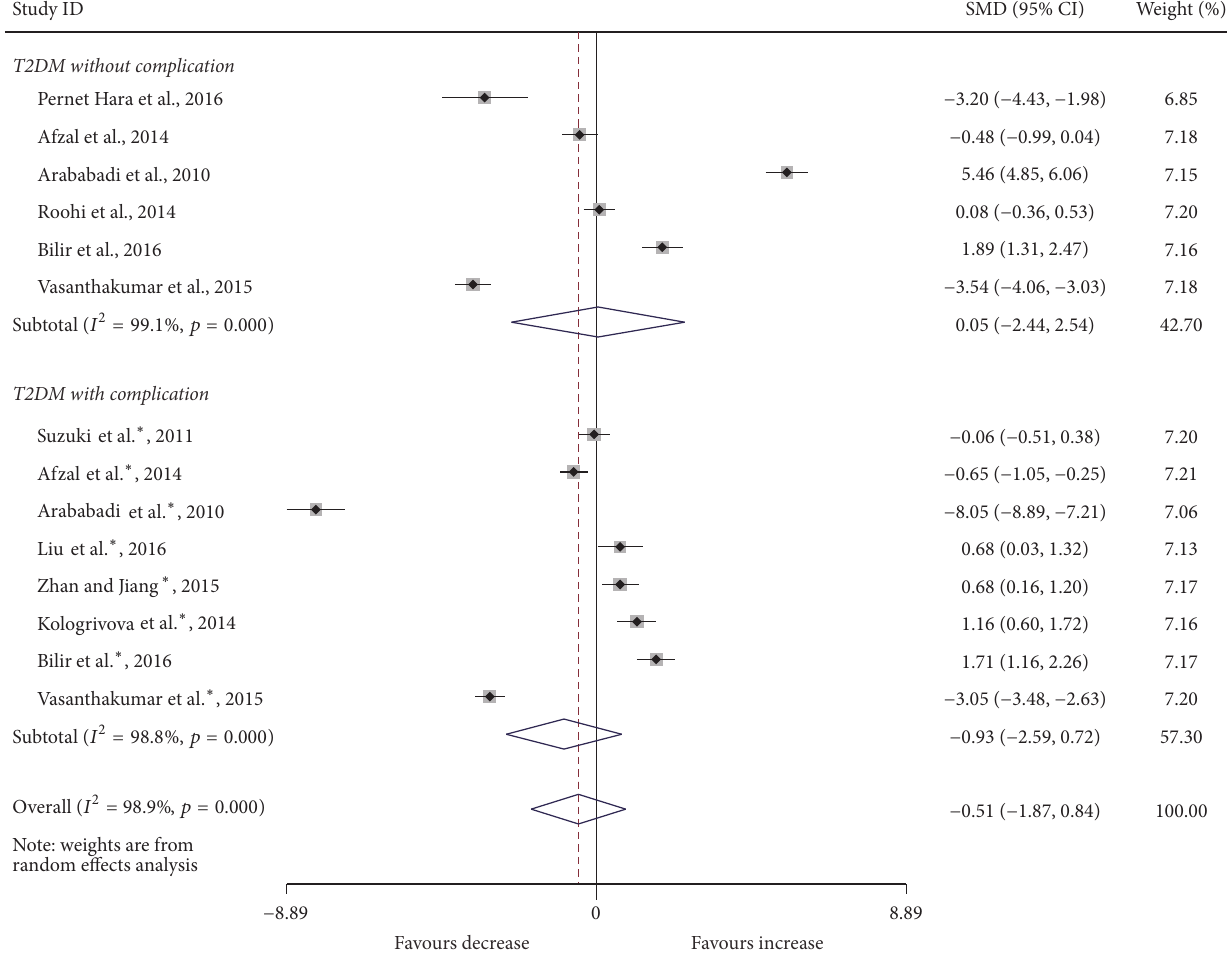
Figure 8: Forest plots for serum IL-17 in T2DM patients and controls with random effects model (T2DM without complication, 𝑝 = 0.969 ; T2DM with complication, 𝑝 = 0.269 ; overall, 𝑝 = 0.459 ). ∗ T 2 DM with complication.